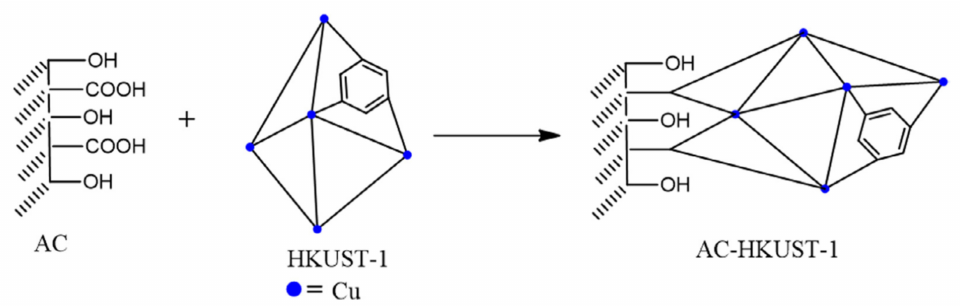
Figure 10. Preparation of HKUST-1-AC. Reprinted with permission from